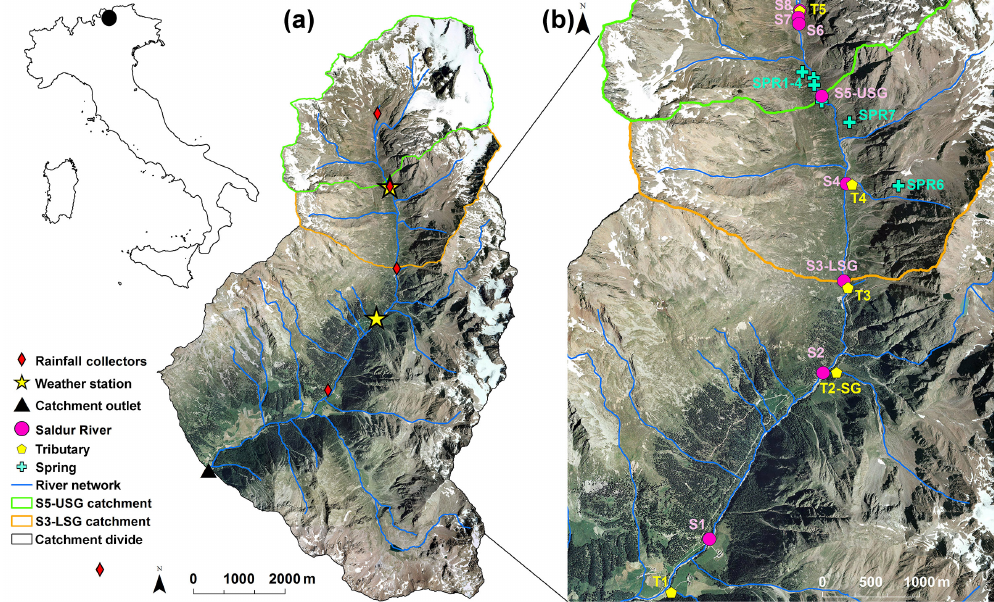
Figure 1. Map of the Saldur catchment, with its localization in the country, and position of field instruments and sampling points. Data from the rainfall collectors were not used in this study but their position is reported for